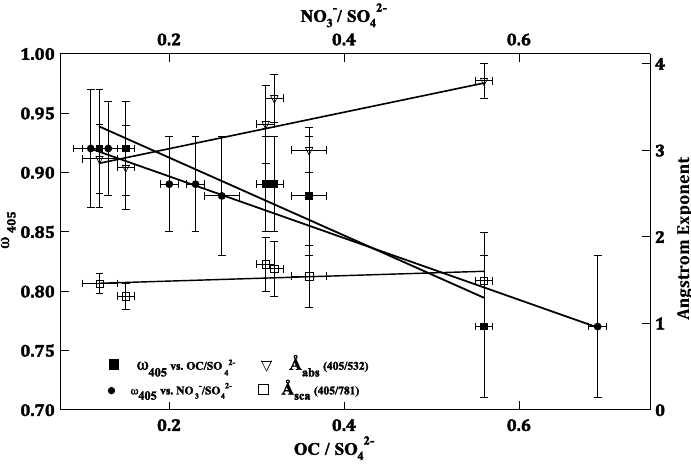
Fig. 2. Single scatter albedo at 405nm plotted against OC/SO 2 − vs. OC/SO 2 − for episodes 3–8 of CAPMEX. The highest ω 405 occurred for the lowest OC/CO 2 − 4 lowest ω 405 occurred for the highest OC/SO 2 −